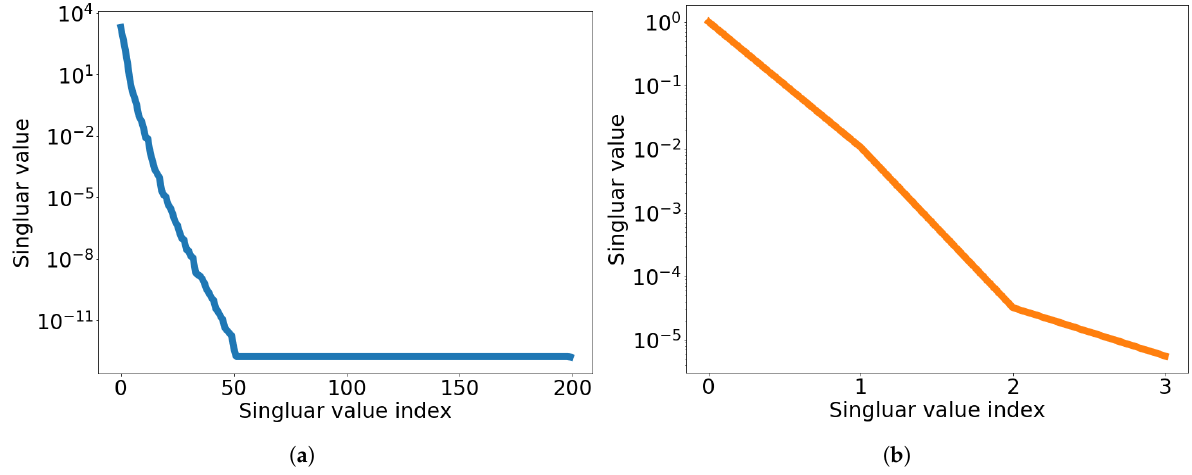
Figure 11. 2D linear convection diffusion equation. Graph of singular value decay. ( a ): Singular value decay of solution snapshot, ( b ): Singular value decay of temporal snapshot for the first spatial basis vector.